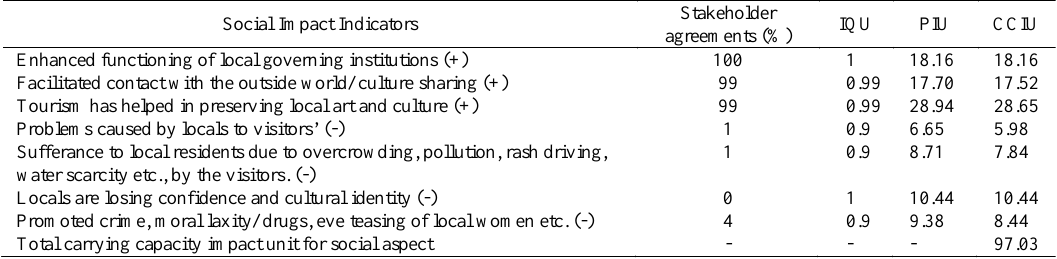
Table 5: Indicator quality unit and carrying capacity impact unit of social carrying capacity component